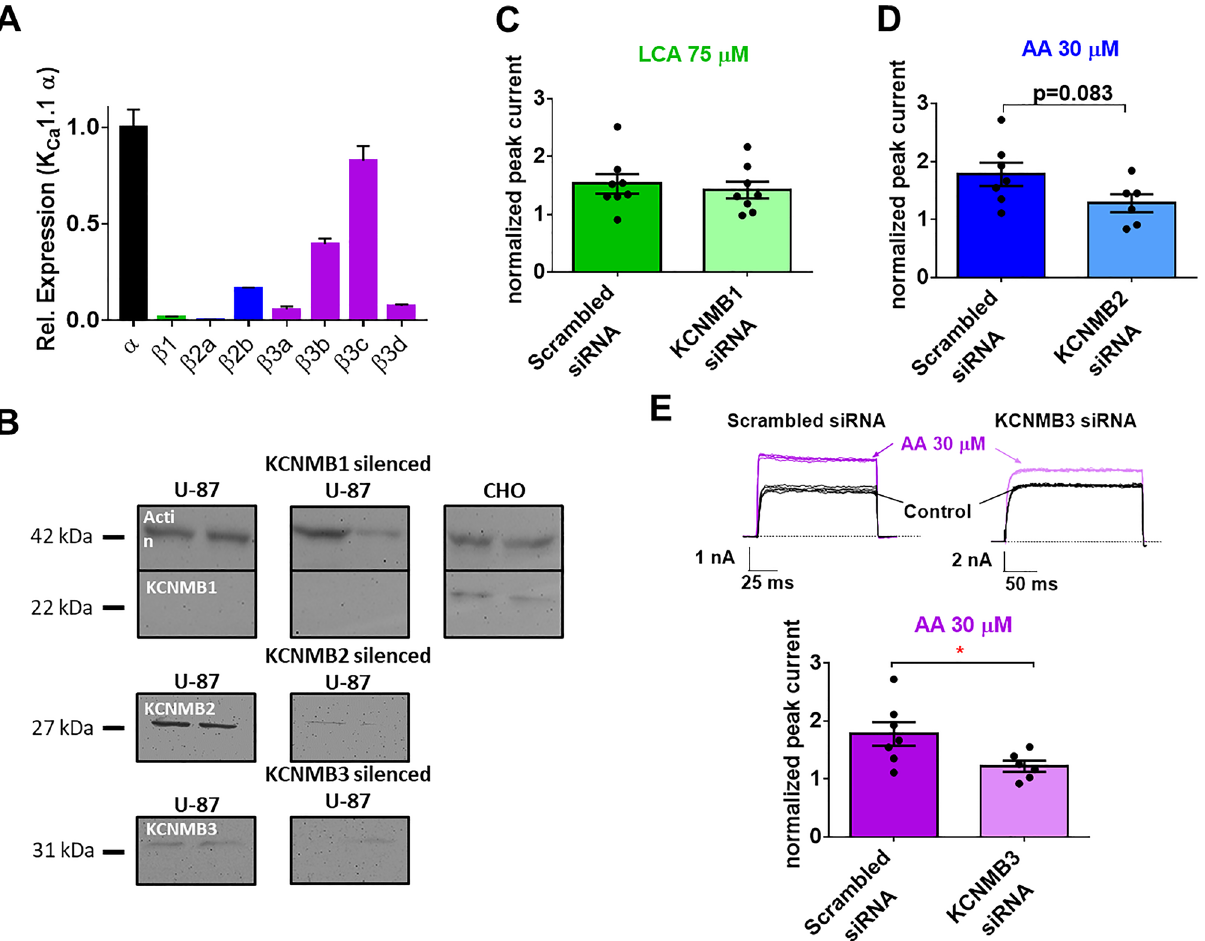
Figure 3. PCR, pharmacology and gene silencing is consistent with the expression of the K Ca 1.1 β3 subunit in U-87 MG cells. ( A ) Results of qPCR experiments assessing the relative expression of the β subunits in the U-87 MG cell line compared to the pore-forming α subunit (black bar). β1, β2 and β3 mRNA levels divided by the expression of the K Ca 1.1 channel α-subunit are represented with green, blue and purple bars, respectively (N = 3, n = 3). ( B ) Western blot of the untreated and gene-silenced U-87 MG cells. The populations were tested in duplicate, the left two lanes are the untreated U-87 MG cells and the right two lanes are untreated (non- transfected and not gene silenced) CHO cells. The middle lane pairs are for the KCNMB1 (β1) , KCNMB2 (β2) and KCNMB3 (β3) silenced populations of U-87 MG, from top to bottom, respectively. The thick band in the top box at 42 kDa corresponds to actin and the 22 kDa marker to the β1 subunit ( KCNMB 1 gene product). In the second box (middle) the β2 band (27 kDa marker, KCNMB2 gene product), and in the third box (bottom) the β3 band (KCNMB3 gene product) are shown (31 kDa marker). (C to E) Pharmacological studies after gene silencing (N Silence = 3). Whole-cell currents were recorded as in Fig. 1D, peak currents were measured and normalized peak currents were calculated as in Fig. 2A and B. ( C ) Effect of 75 μM LCA on control scrambled siRNA (dark green bar, n = 8) and on β1 silenced ( KCNMB1 siRNA transfected, light green bar, n = 8) U-87 MG cells. ( D ) Effect of 30 μM AA on the β2 silenced ( KCNMB2 siRNA transfected, light blue bar, n = 6), and ( E ) on the β3 silenced ( KCNMB3 siRNA transfected, light purple bar, n = 6), compared to the scrambled siRNA transfected groups (dark blue and dark purple bars respectively, n = 7). Insets in E) show the raw currents obtained in a scrambled RNA (left) and in a KCNMB3 siRNA treated cell before (Control, black current traces) and after the application of 30 μM AA (purple current traces). Voltage protocols and solutions are as in Fig. 1D. Throughout the figure, bars and error bars indicate mean ± SEM for the indicated number of experiments (black symbols), * p < (Fig. 3A) suggest that K Ca 1.1 β3 may be the main auxiliary subunit associated with K Ca 1.1 in the membrane of glioblastoma cells.